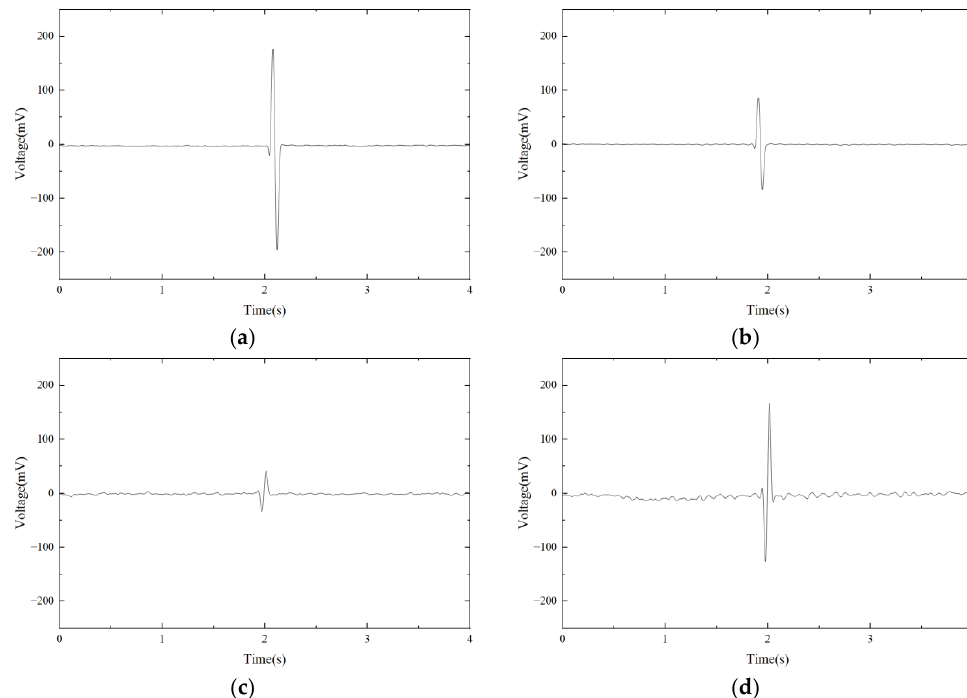
Figure 10. The output voltage waveform of 480 μm iron particles at different excitation frequencies .